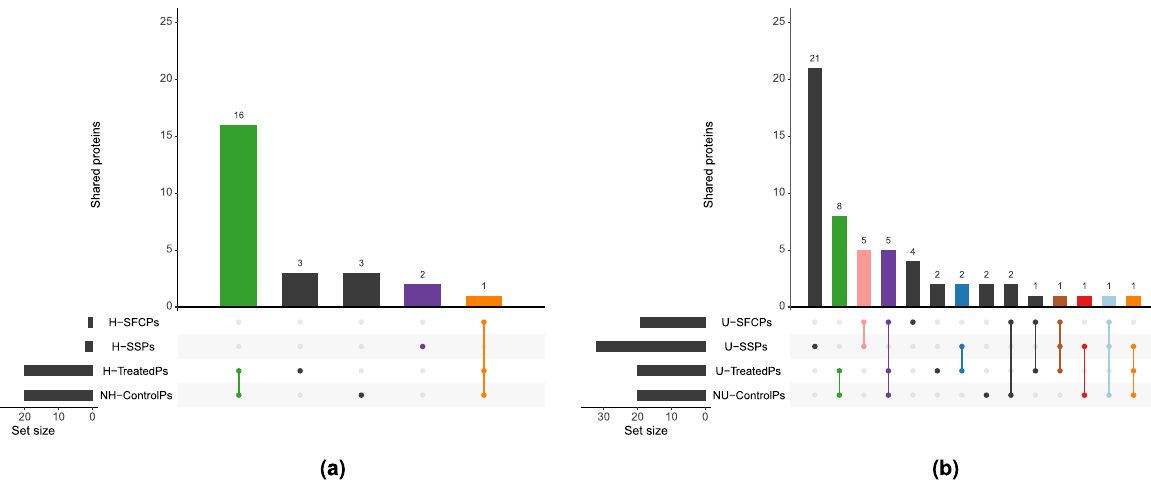
Figure 5. High degree was not always predictive of fold change or significance. Each bar, in each upset plot, represents the number of proteins that belonged to a set or that were shared across two, or more, sets. Sets are listed on the left panel. Set size represents the number of proteins for each of the listed sets. In (a) , the comparison between highest scoring proteins in terms of degree (H-TreatedPs and NH-ControlPs), H-SFCPs, and H-SSPs for the NH-H comparison, is shown. In (b) , the comparison between highest scoring proteins in terms of degree (U-TreatedPs and NU-ControlPs), U-SFCPs, and U-SSPs for the NU-U comparison, is Degree, experimental significance, and fold change were not always related. To better under- stand the properties of degree in WNNets, fold change was computed on the set of 79 proteins. Results showed that only 1 protein scored as H-SFCPs for the NH-H samples comparison, while 19 proteins scored as U-SFCPs for the NU-U samples comparison. Concerning the NH-H samples comparison, the two sets of high-degree proteins, i.e. NH-ControlPs and H-TreatedPs, had 17 proteins in common (Fig. 5a, green and orange bars) of which 1 was shared between these two sets and H-SFCPs (Fig. 5a, orange bar). On the other side, 2 H-SSPs were found and none of them was shared (Fig. 5a, purple bar). Concerning the NU-U treated samples comparison, 14 proteins were shared between the two sets of high- degree proteins, i.e. NU-ControlPs and U-TreatedPs (Fig. 5b, green, purple, and orange bars). 5 of these pro- teins were also shared with the set of U-SFCPs (Fig. 5b, purple bar). Also, 7 out of 32 U-SSPs were shared with U-SFCPs (Fig. 5b, pink, brown, and light-blue bars). Finally, 4 and 3 out of 32 U-SSPs were found shared with U-TreatedPs and NU-ControlPs, respectively (Fig. 5b, blue, brown, and orange for U-TreatedPs and red, light- blue and orange bars for NU-ControlPs). Notably, 14 proteins were shared between all the high-degree proteins sets (see Supplementary materials,